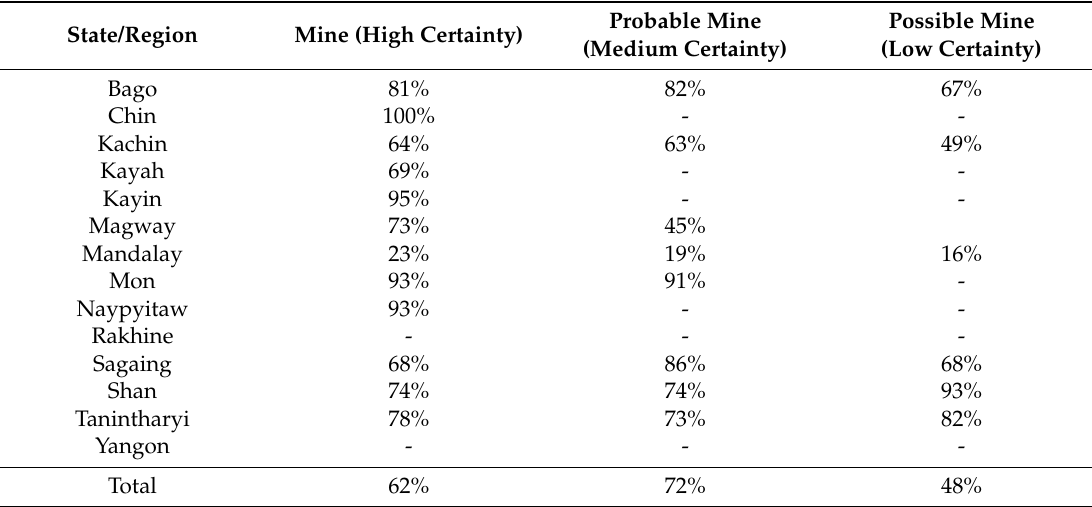
Table 5. Percent of mining area bare ground that was newly cleared since 2002. Only states and regionss with over 100 ha of mining detected were included. Probable Mine Possible Mine State/Region Mine (High Certainty) (Medium Certainty) (Low Certainty) Bago 81% 82% 67% 100% - - 49% - -